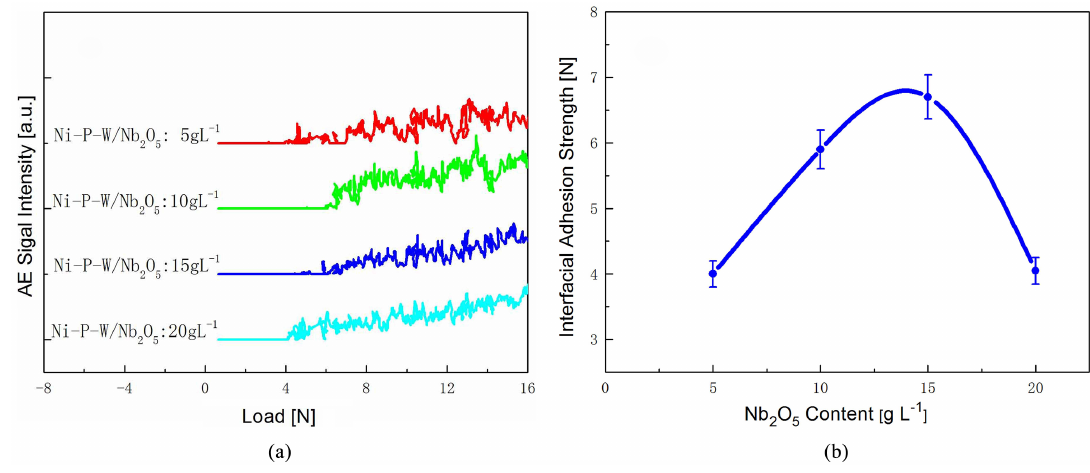
Figure 4. Acoustic emission signal (a) and the relationship of critical stress vs Nb